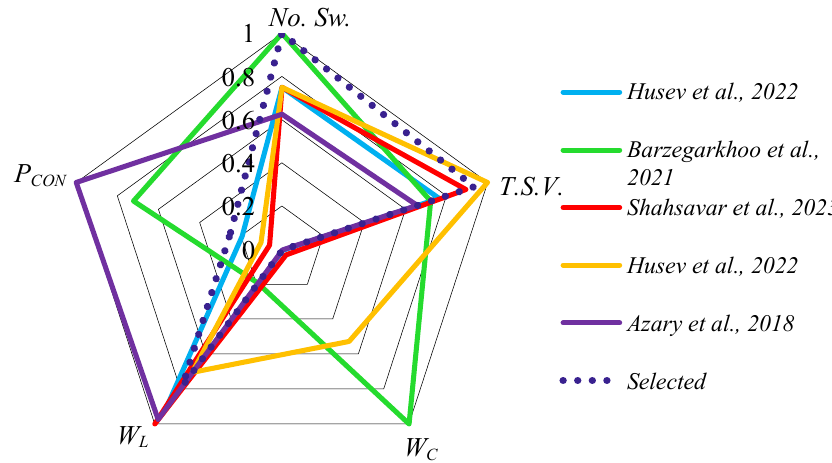
Figure 5. Radar chart of the compared topologies in [9,24,25,27,29].